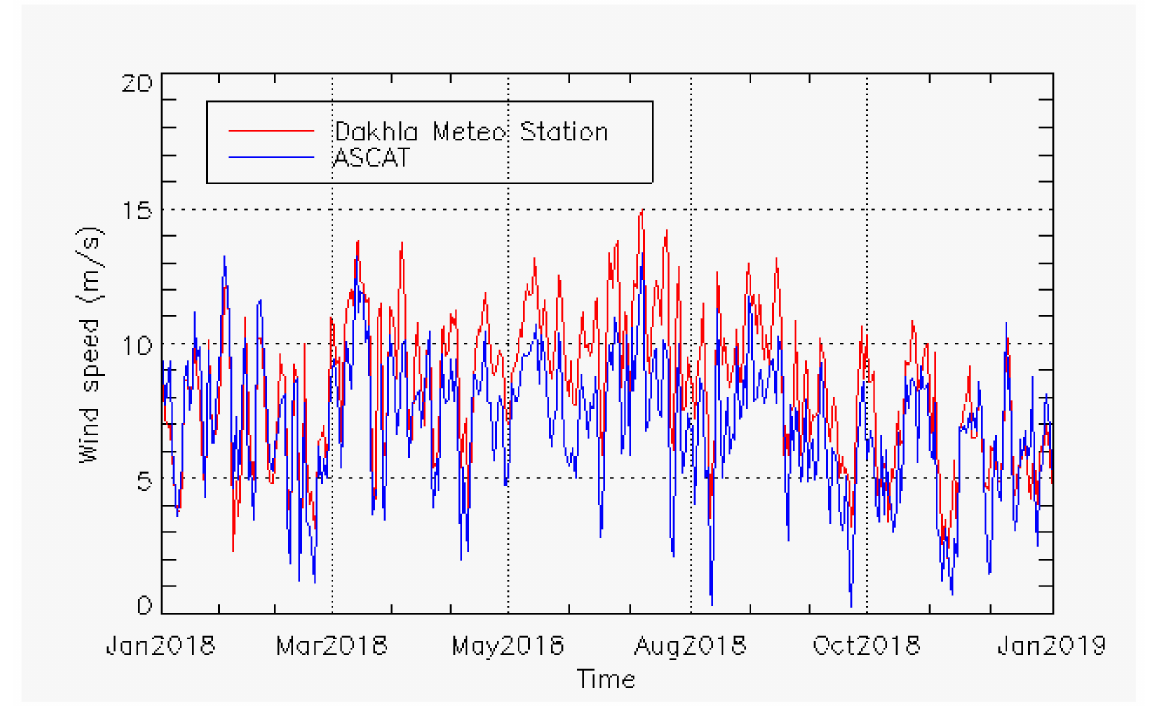
Figure 3. Temporal wind variability based on daily in-situ measurement and Advanced Scatterometer (ASCAT) product during the year of